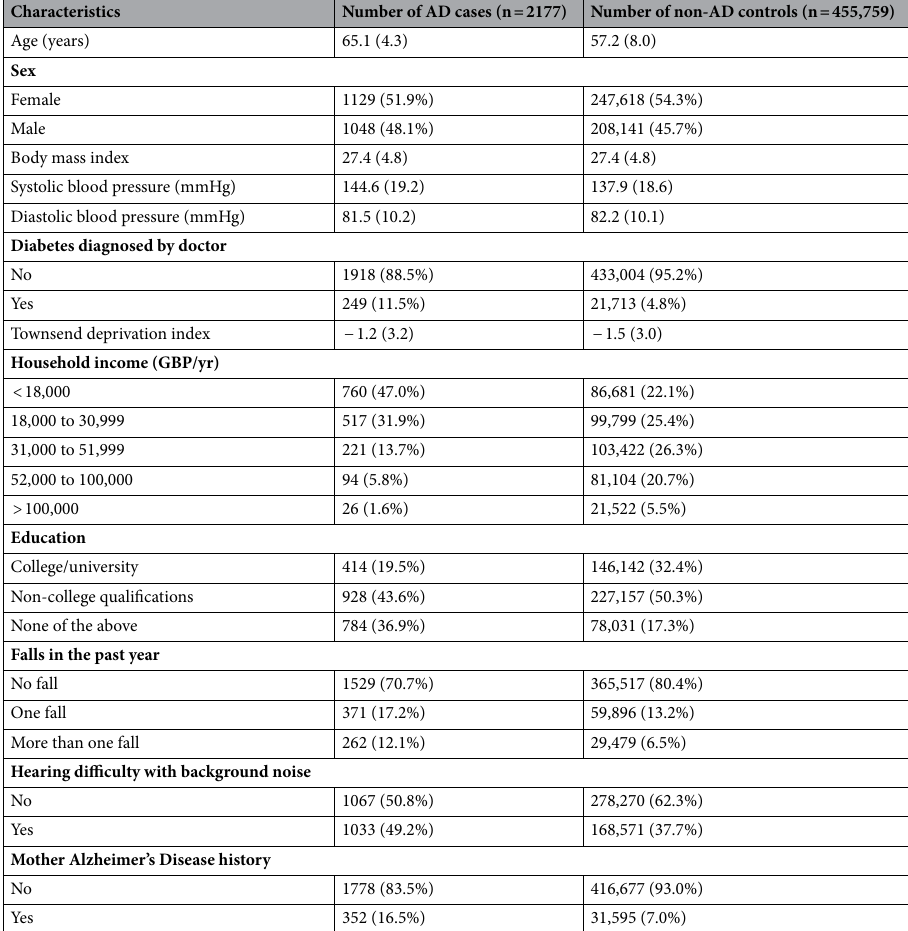
Table 1. Comparison of subject characteristics between AD cases and non-AD controls (age 40 +). For continuous data, mean and standard deviation (sd) for each group were shown. Missing data percentage: